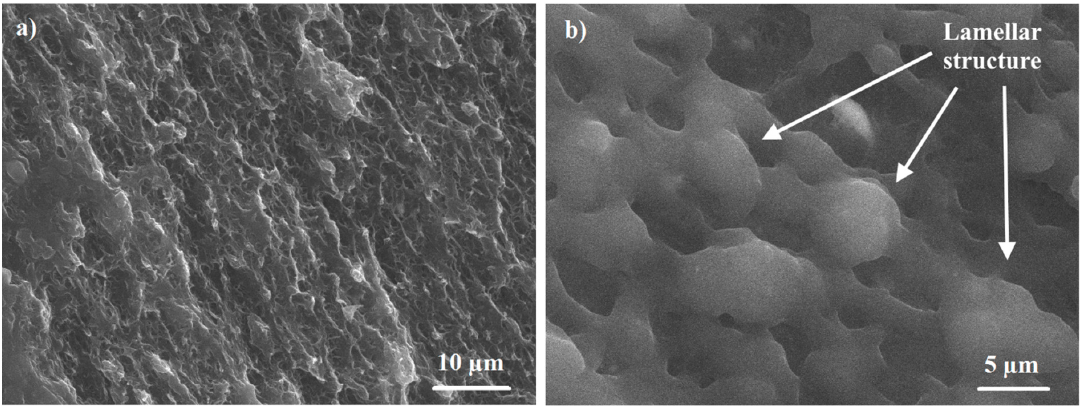
Figure 6. SEM micrographs showing typical supra-molecular structure of the UHMWPE/PE-wax xerogel with different magnification.